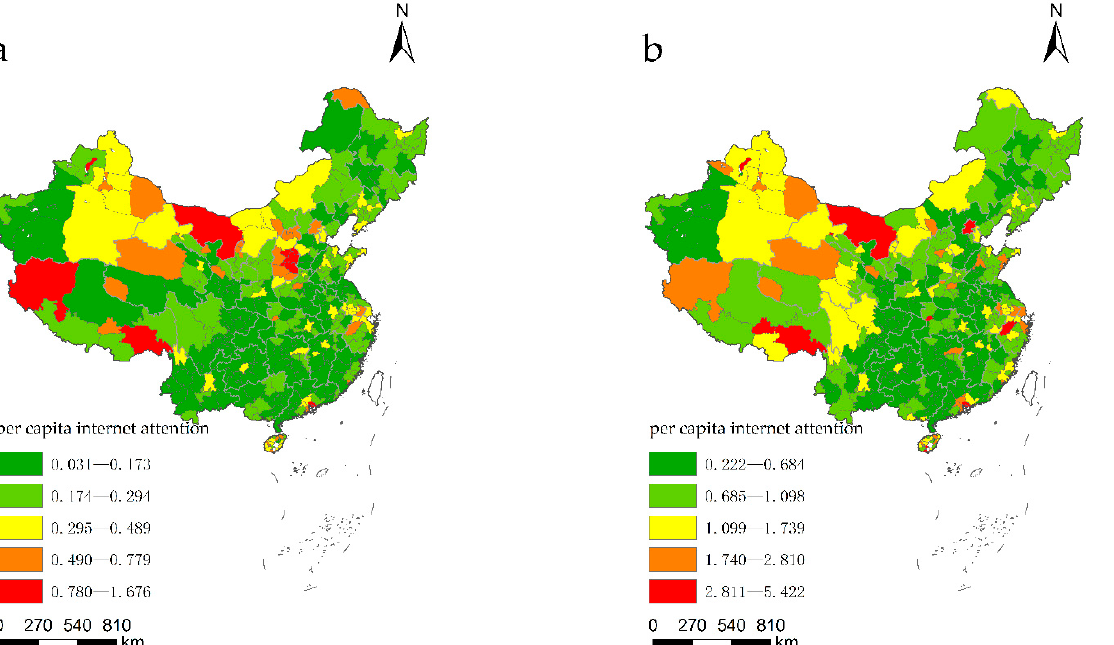
Figure 6. Municipal geographical distribution of per capita internet attention for torrential rain. (Note: ( a ) the per capita internet attention of Shanxi Province; ( b ) the per capita internet attention of Henan Province). (The map is based on the standard map of the Technical Review Centre for Maps of the Ministry of Natural Resources (review number: GS (2019) 1822), with no modifications to the base map).